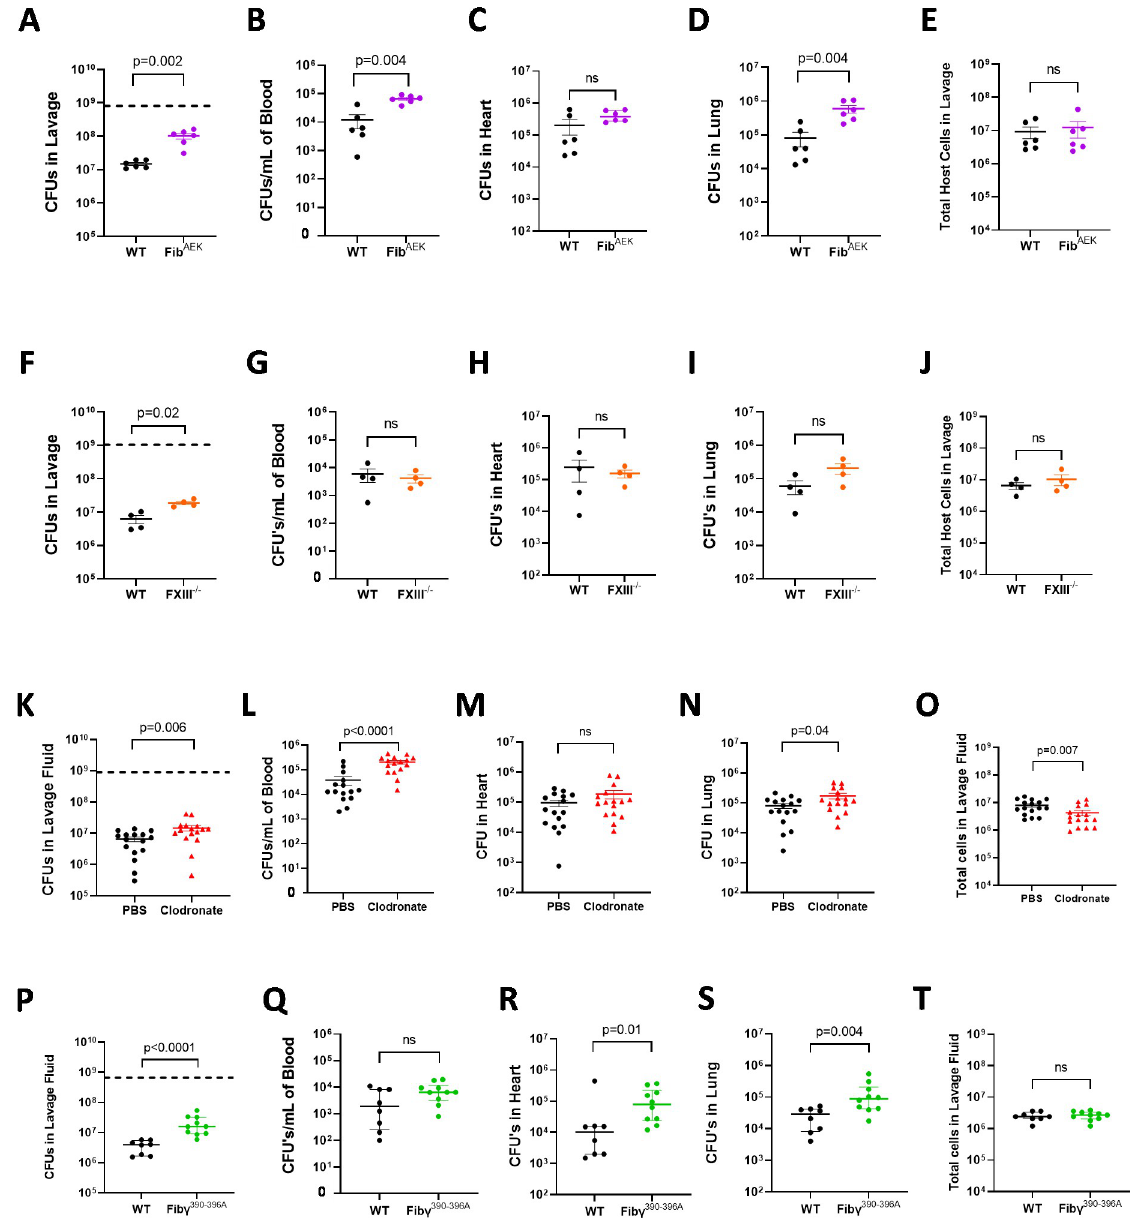
Fig 7. Fibrin-macrophage driven host antimicrobial function limits dissemination, but fibrin matrix formation alone is not sufficient to suppress systemic spread of S. aureus out of the peritoneal cavity. Total live bacteria in (A) lavage fluid, (B) blood, (C) heart and (D) lung and total host cell counts (E) from WT and Fib AEK mice 1 hr after infection with 8.8x10 8 CFUs of WT S . aureus USA300. Total live bacteria in lavage fluid (F), blood (G), heart (H) and lung (I) and total host cell counts (J) from WT and FXIII -/- mice 1 hr after infection with 1x10 9 CFUs of WT S . aureus USA300. Total live bacteria in lavage fluid (K), blood (L), heart (M) lung (N) and total host cell count (O) from WT mice treated with PBS or Clodronate liposomes 1 hr after infection with 9x10 8 CFUs of WT S . aureus USA300. Total live bacteria in lavage fluid (P), blood (Q), heart (R) and lung (S) and total host cell counts (T) from WT and Fib γ 390-396A mice 1 hr after infection with 6.7x10 8 CFUs of WT S . aureus USA300. Data are presented as mean ± SEM and statistical significance was determined by Mann-Whitney u- test.